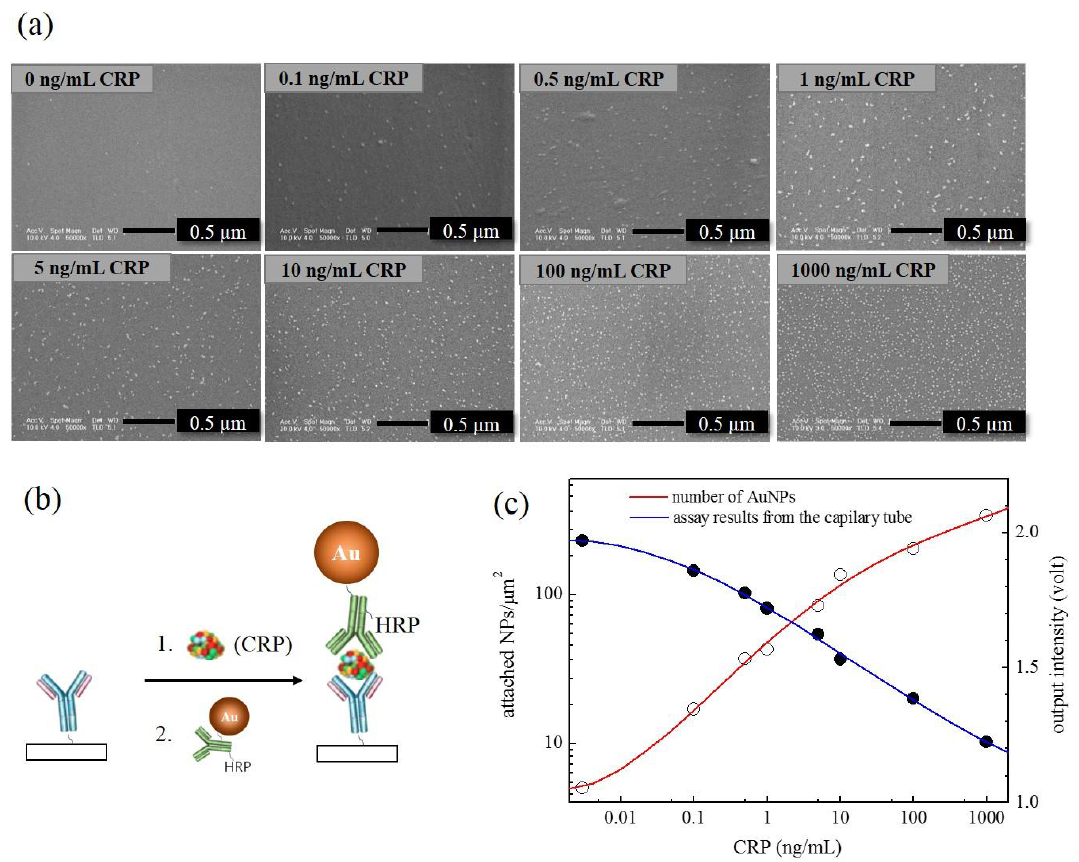
Figure 6. ( a ) Images of the FE-SEM produced from the pieces of the capillary tubes that had undergone “AuNP capillary ELISA” with varying amount of CRP, ( b ) schematic representation of the “AuNP ELISA”, and ( c ) the plots obtained from the “AuNP capillary ELISA” based on optical density (blue line) and number of AuNPs involved (red line).